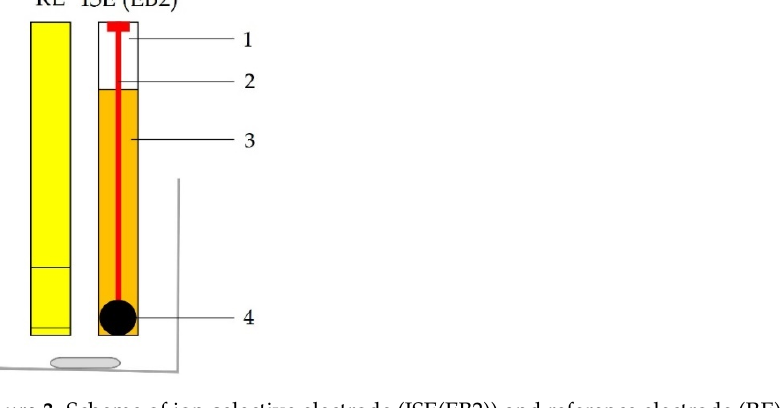
Figure 3. Scheme of ion-selective electrode (ISE(EB2)) and reference electrode (RE); ( 1 —epoxy plate, 2 —copper layer, 3 —non-conductive lack, 4 —ion-selective membrane)).